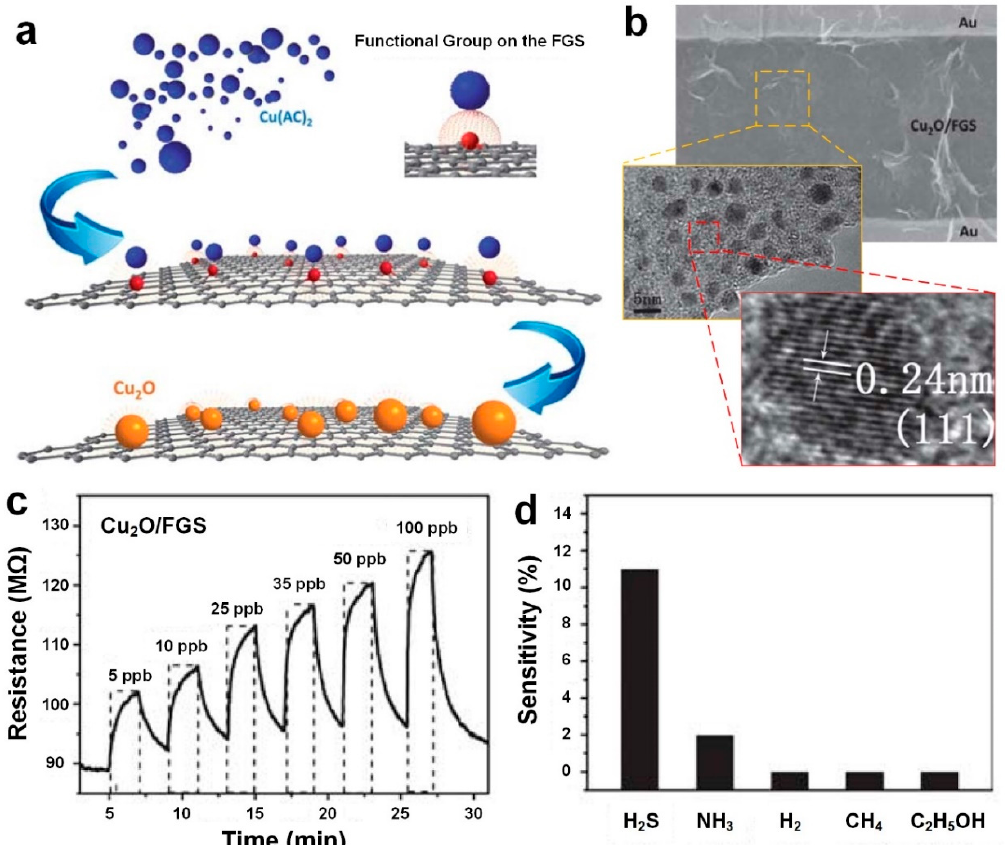
Figure 5. ( a ) Schematic illustration of Cu 2 O-FGS through an in-situ process. ( b ) SEM and TEM images of Cu 2 O-FGS, covering gold interdigitated electrodes. ( c ) Dynamic sensing response of Cu 2 O-FGS sensor upon exposure to H 2 S gas at different concentrations of 5 to 100 ppb. ( d ) The device sensitivity towards H 2 S (5 ppb), NH 3 (25 ppm), H 2 (25 ppm), CH 4 (25 ppm) and C 2 H 5 OH (25 ppm) [6]. Reproduced with permission [6], Copyright 2013, RSC Publishing.